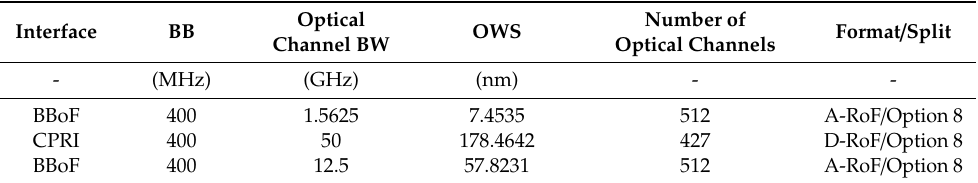
Table 3. Calculated comparative parameters for detailed scenario No. 1 to switch from D-RoF to A-RoF format (the optical channel count-down is starting from wavelength equal to 1675 nm)—Figures 9 and 12 (128-element antenna-array and 4-sector unit).